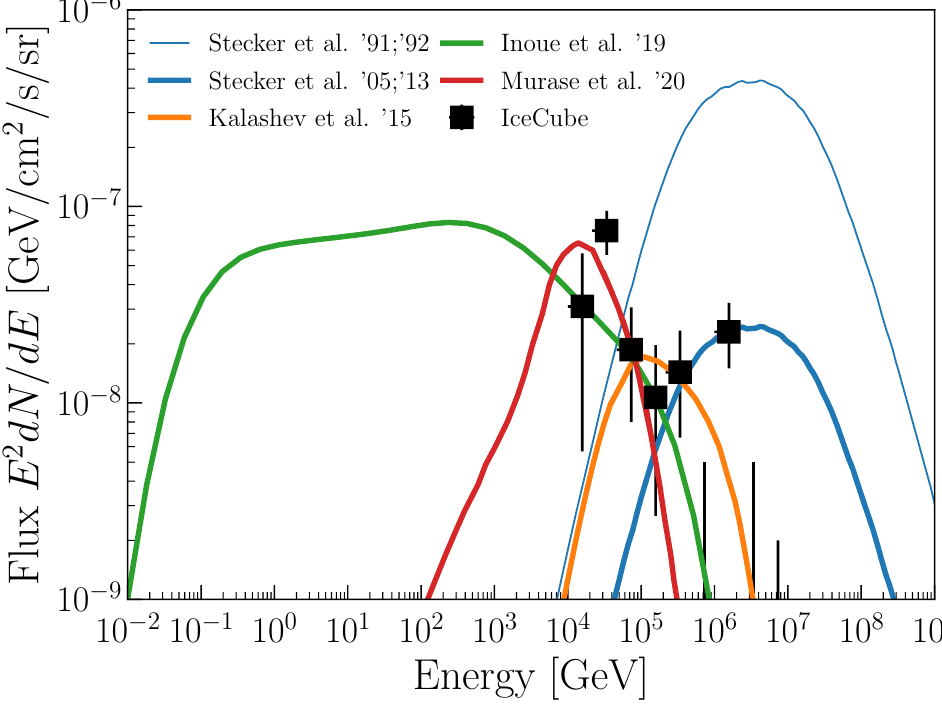
Figure 14. The cosmic neutrino background spectra per flavor from AGN coronae, showing the cur- rently available models [18,33,34,149]. The original prediction by Stecker et al. [27,35] is also shown. Stecker [149] considered a similar model to the one originally proposed [35], but the background flux is assumed to be lower by a factor of 20 to match the IceCube